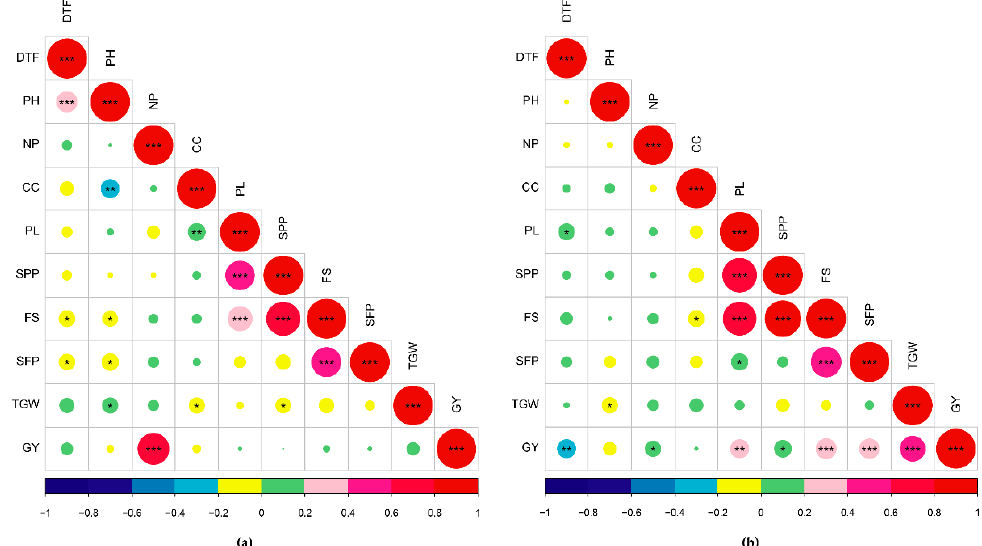
Figure 1. Graphical correlation matrix for traits evaluated in ( a ) non-stress and ( b ) reproductive stage drought stress trials in 2019MS. DTF, Days to flowering; PH, plant height; NP, number of panicles; CC, chlorophyll content; PL, panicle length; SPP, number of spikelet per panicle; FS, number of filled spikelet per panicle; SFP, spikelet fertility percentage; TGW, thousand-grain weight; GY, grain yield; * significant at p < 0.05, ** significant at p < 0.01, *** significant at p < 0.001.